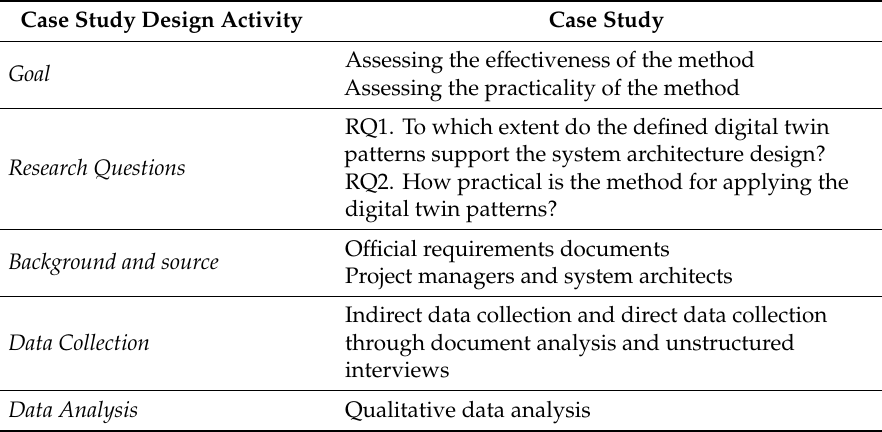
Table 4. Case study design.